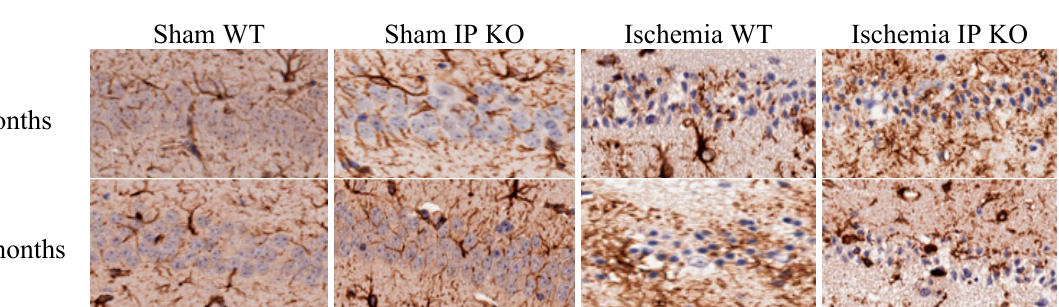
Figure 4. Astrocyte reactivity in young and aged WT and IP KO sham and ischemic mice after 12-min global cerebral ischemic insult. ( A ) Representative images of brain sections show astrocyte immunostaining. ( B ) Quantification of GFAP-positive cells in the hippocampal CA1 subfield on day 7 after ischemia ( n = 3 per group). n.s. = no significance. A Sham WT Sham IP KO Ischemia